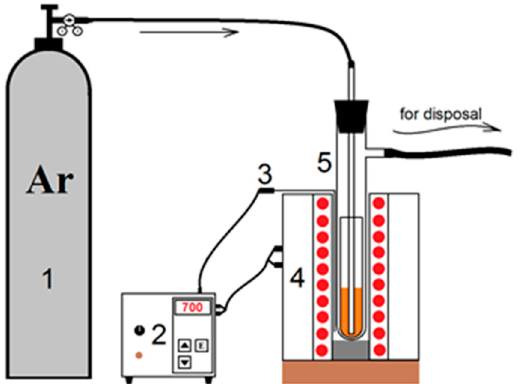
Figure 1. Installation for the synthesis of yttrium oxysulfate. 1—argon tank; 2—thermoregulator; 3—thermocouple; 4—vertical oven; 5—quartz reactor.